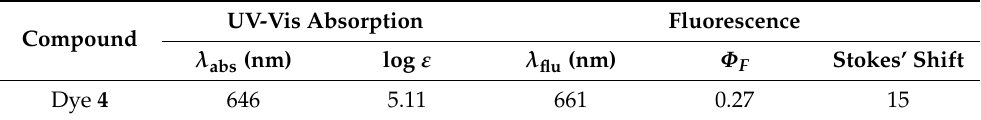
Table 1. UV-vis absorption and fluorescence data of sulfo-Cy5 carboxylic acid 4 (1 × 10 − 6 M) at pH 7.4 in